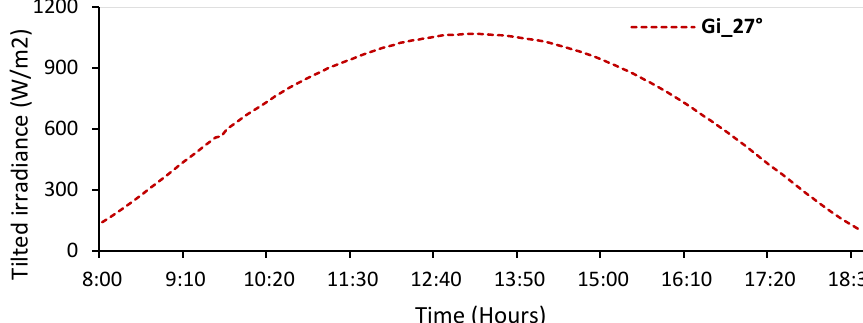
Figure 6. Measured tilted irradiance (clear sky day).